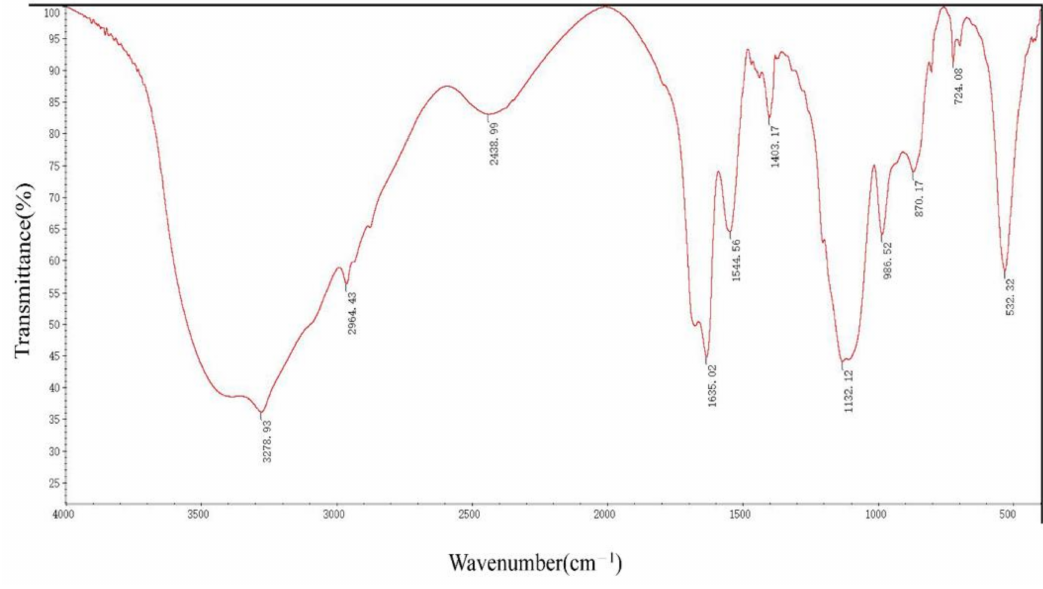
Figure 4. Infrared spectrogram analysis of